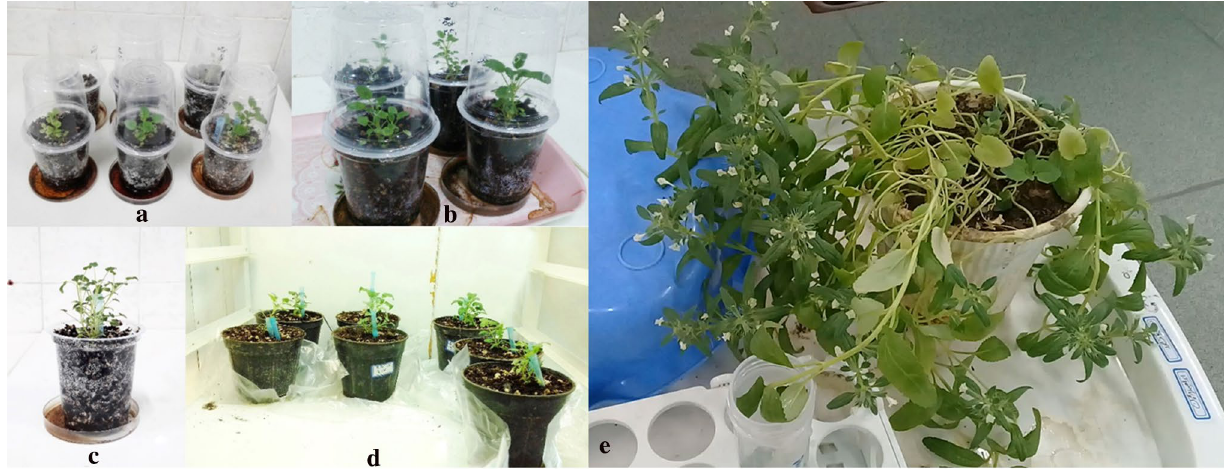
Figure 4. Acclimatization of regenerated plantlets. ( a ) The early stages of adaptation: transfer the plantlets to the pots containing 1:1 ratio of coco peat and perlite mix and covering them with transparent plastic shield; ( b ) making 2–3 holes in the shields to easy adapt plants; ( c ) removing of the plastic cover after 3–4 weeks; ( d ) transfer of plantlets to larger pots containing mixture of farm soil, compost, and sand at the late stage of adaptation; ( e ) a plant at flourishing stage.